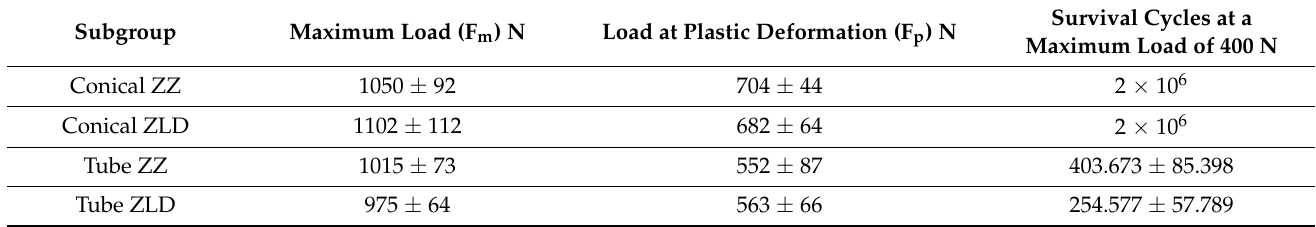
Table 3. Mechanical properties.